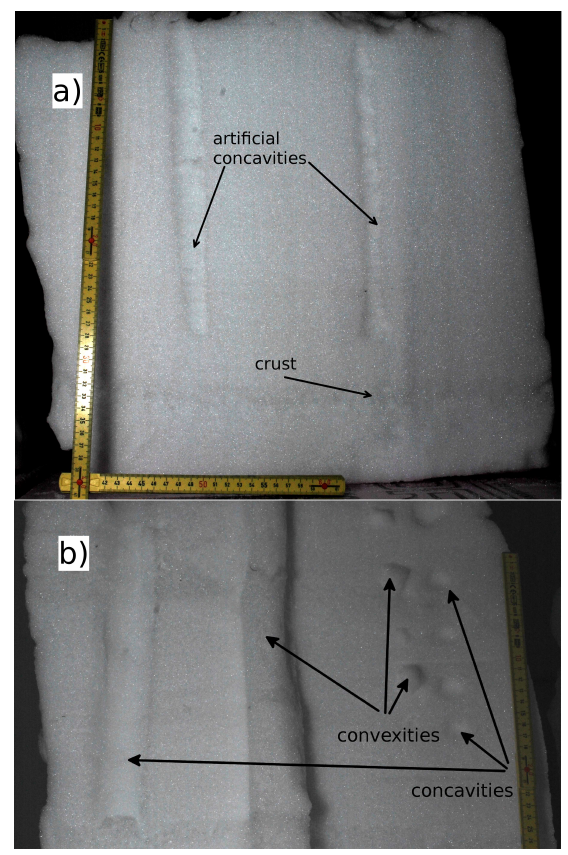
Fig. 4. Horizontal temperature profiles at the first and last time step at vertical pixel location 100 (see Fig. 2). Areas with a slower cool- ing process are marked in red circles which correspond to the shovel scours.